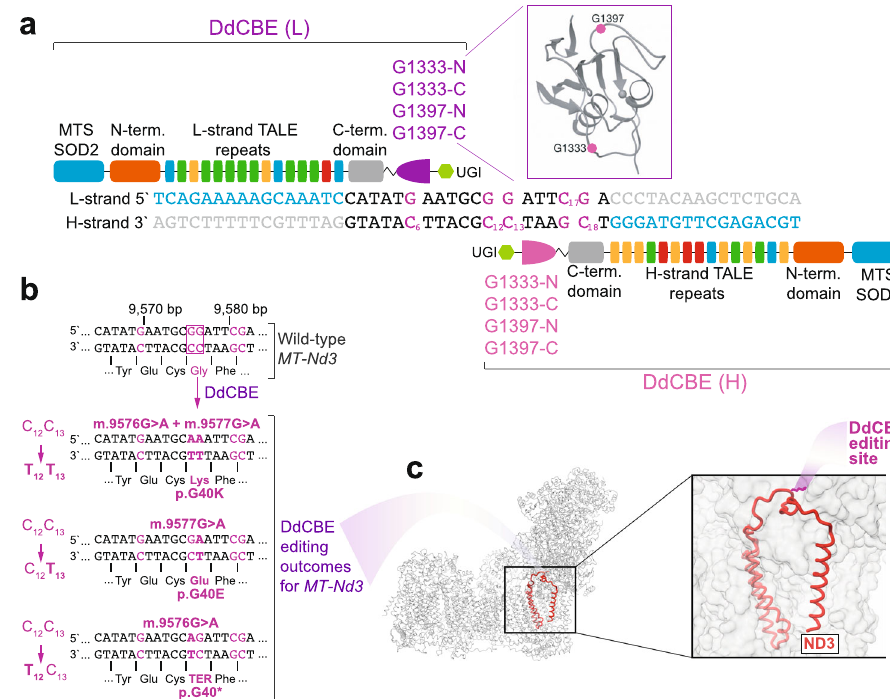
Fig. 1 Design of DdCBEs and mutagenesis site. a The architecture of DdCBE monomers targeting m.9576 G (C 12 ) and m.9577G (C 13 ). The DNA speci fi city is provided by TALE domains. In each experiment, different DddA tox splits are used (G1397 or G1333, purple) to achieve editing of “ TC ” sites. MTS SOD2 mitochondrial targeting sequence from superoxide dismutase 2, UGI uracil glycosylase inhibitor, L-strand or (L) light mtDNA strand, H-strand or (H) heavy mtDNA strand. b The details and possible outcomes of m.9576 G (C 12 ) and m.9577G (C 13 ) editing. The purple box indicates the desired editing sites; other potential editing sites are indicated in purple. c The structural model of mouse complex I with indicated MT-ND3 subunit (red). The inset shows the location of MT-ND3 p.G40K mutation on the evolutionary conserved MT-ND3